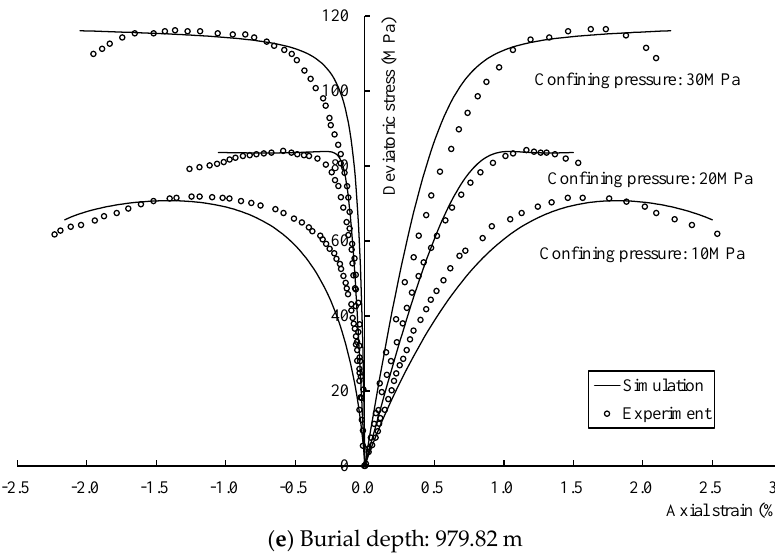
Figure 9. Simulation of triaxial compression tests of clastic sandstone under various confining pressures.